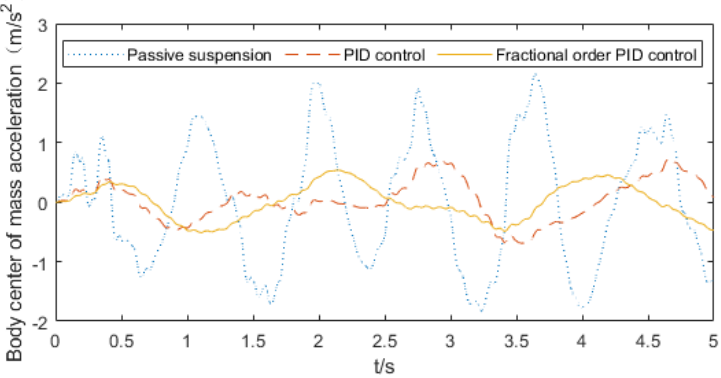
Figure 16. Simulation image of body center of mass acceleration.